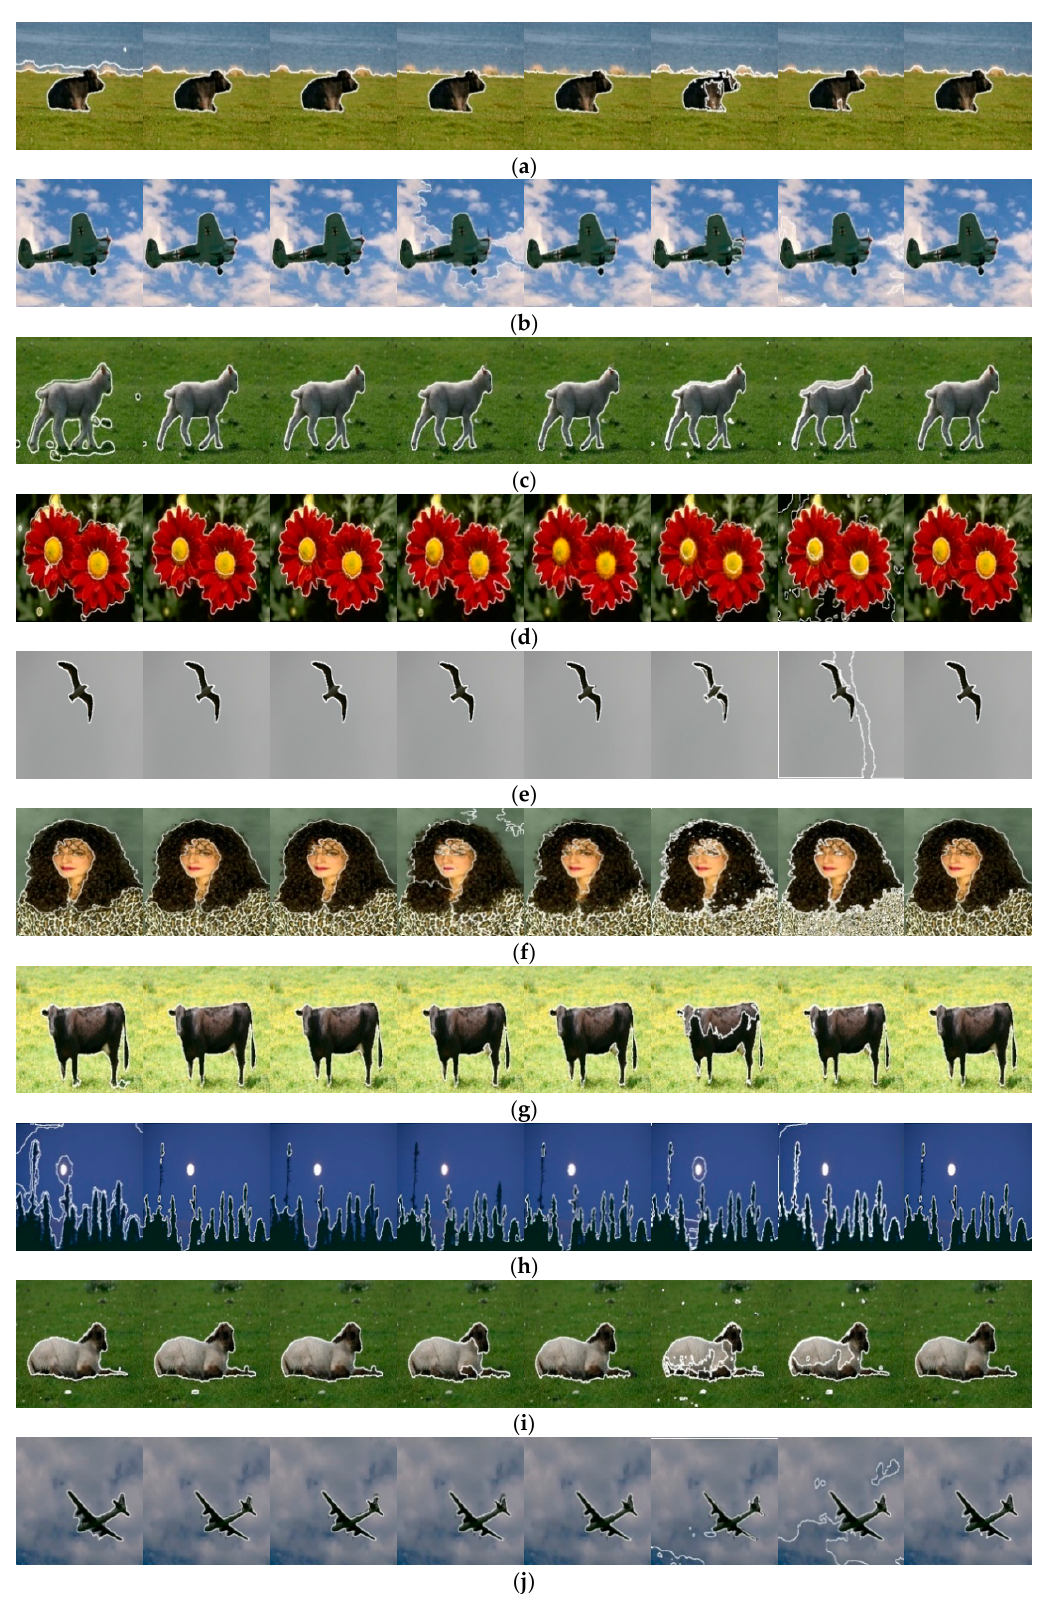
Figure 3. Comparative segmentation results for various algorithms. ( a – j ) are images from [49–52]. The 1st to the 8th columns are the results for FRCGMM, L1FS, PCFRC, SFFCM, AFCF, BP, DFC and FBRC, respectively.